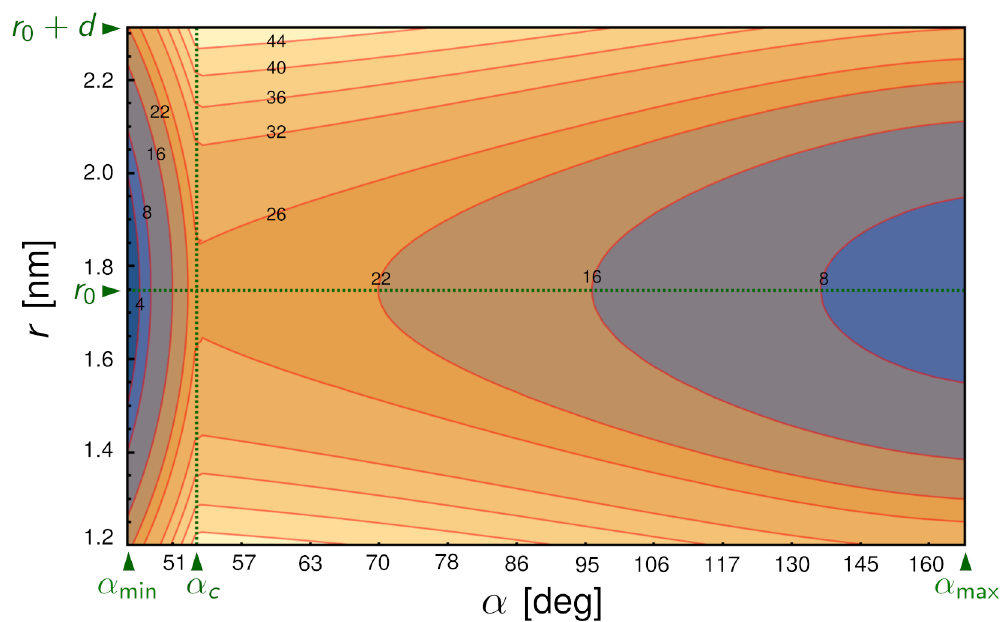
Fig 2. Energy landscape of the Hamiltonian U from Eqs (1) and (2) in terms of r and α = π − θ − ϕ at force F = 0, with the parameters given in Table 1 and described in the text. Energy contour labels are in units of k corresponds to the transition angle α , the horizontal dashed line to the natural bond length r 0 , and the top edge to the c distance r 0 + d beyond which the bond ruptures. The energy barriers to rupture are smaller in the region α (cid:20) α c on the left, relative to the region α > α on the right. Since applied force F > 0 tilts the landscape toward larger inter-domain angles α , c the mean bond lifetime will initially increase with